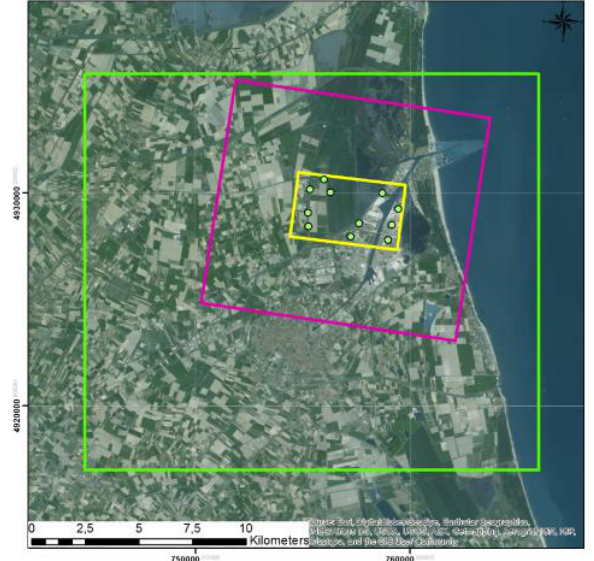
Figure 2. In the green square, the main study area. In purple and yellow, the footprints of the TerraSAR-X SL and ST. The green dots are the location of the GPS 3D vertices.